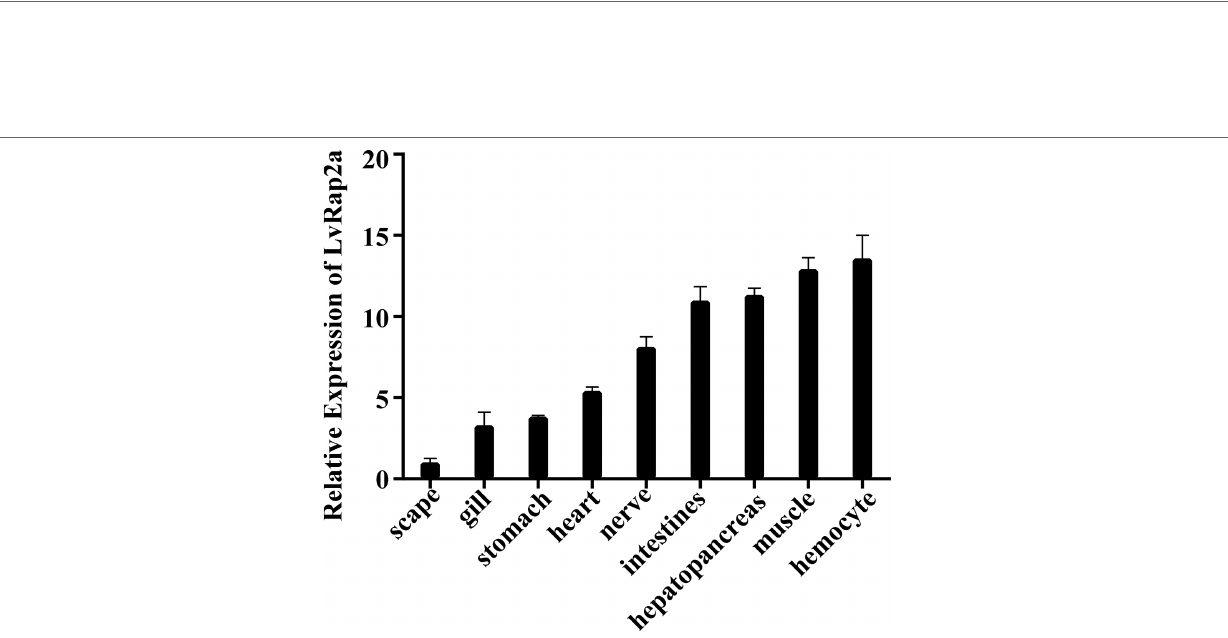
FIGURE 1 | Multiple sequence alignment and phylogenetic tree analysis of Rap2a proteins. (A) Multiple sequence alignment of Rap2a proteins. The conserved Ras domain was boxed with red lines. The Rap characteristic Thr residue at position 61 was marked with red triangle and Rap2 characteristic Phe residue at position 39 was marked with black triangle. (B) Neighbor-joining method was used to construct the phylogenetic tree of Rap2a proteins.